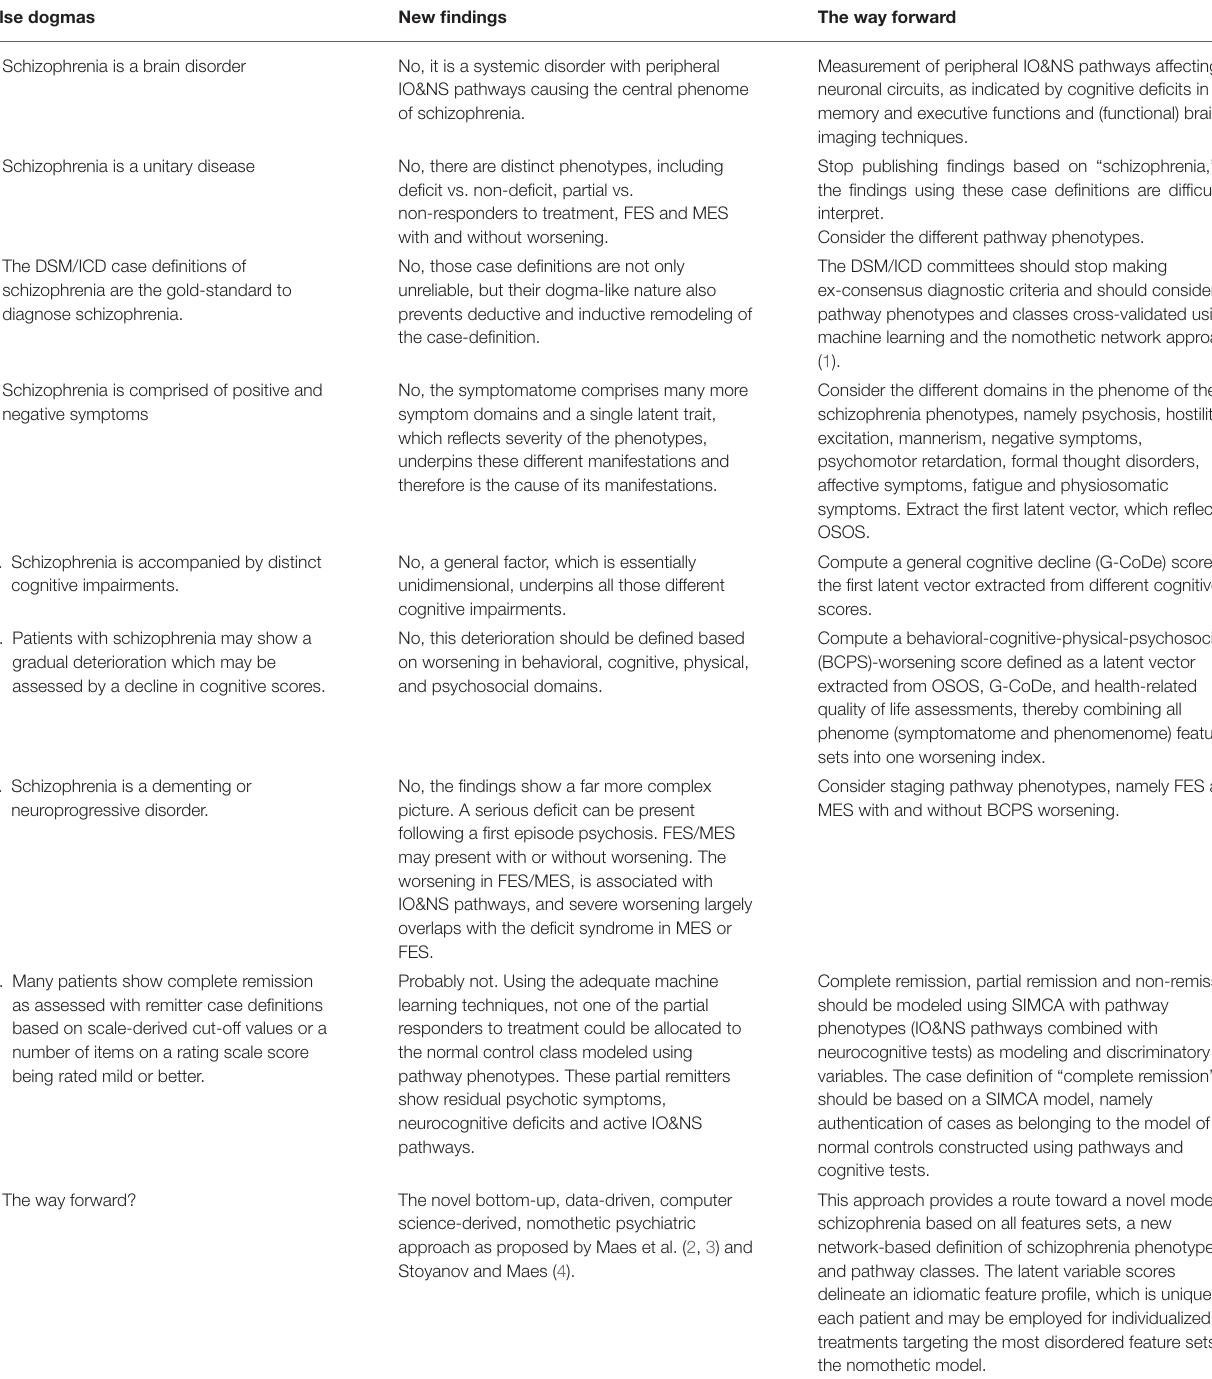
TABLE 1 | False dogmas in schizophrenia research and the way